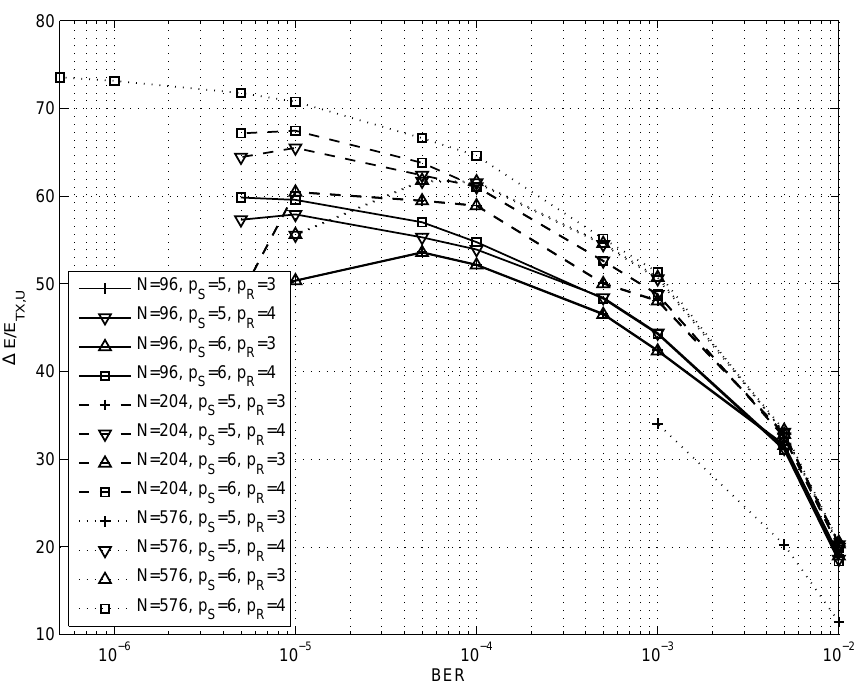
Figure 6. Percentage of energy per bit saved as a function of the BER for n = 3 .